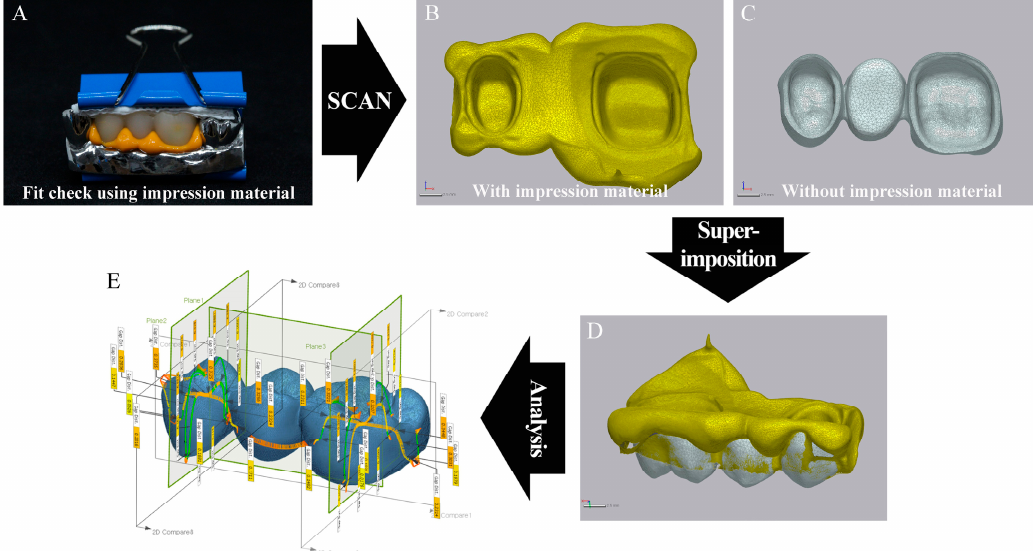
Figure 5. Measurements of the marginal and internal fit. ( A ) Fit check using impression materials. ( B ) Inner surface scan of the 3-unit fixed dental prosthesis (FDP) with impression materials. ( C ) Inner surface scan of the 3-unit FDP without impression materials. ( D ) Superimposition. ( E ) Measurements of the marginal and internal fit in a hypothetical plane.